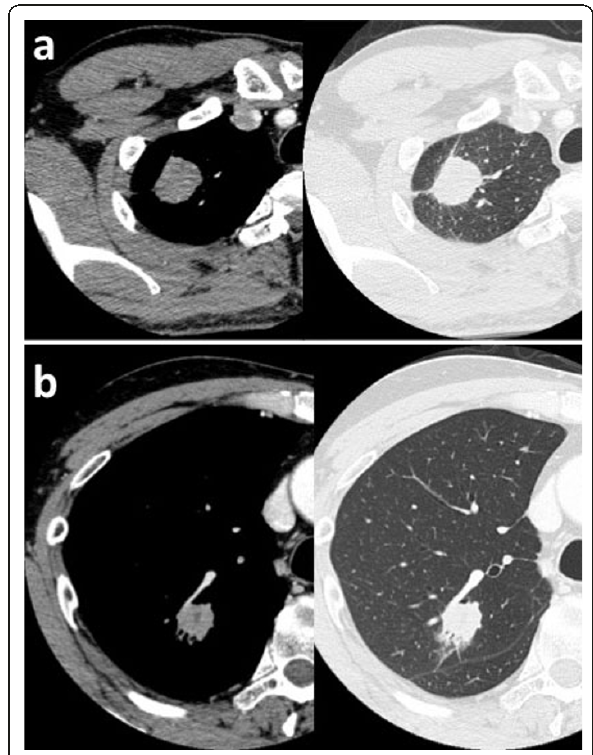
Figure 1 Enhanced chest CT of the lung . Chest CT of case 1 (a) and case 2 (b) showed a tumor of the right upper lobe of the lung. (a) Chest CT revealed a tumor with pleural indentation, without ground glass opacity (GGO). The tumor was 32 mm in diameter and mildly enhanced. (b) Chest CT revealed a nodule with GGO, pleural indentation, air bronchogram and venous involvement. The nodule was 29 mm in diameter and mildly